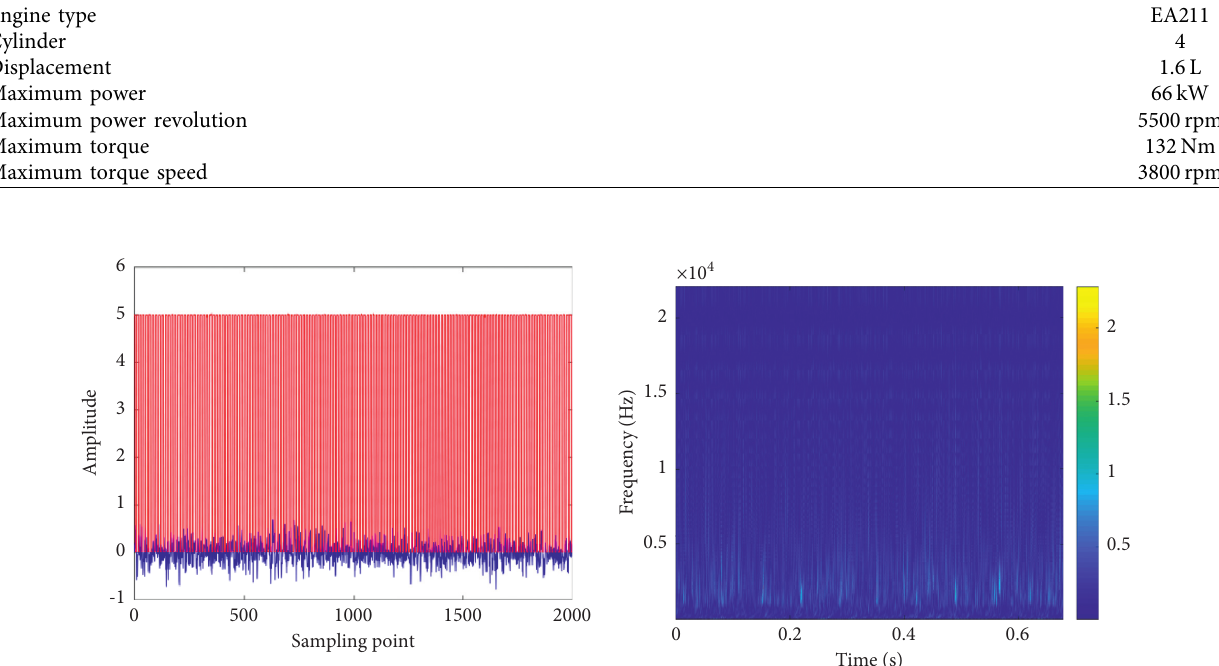
Figure 7: Automobile engine fault detection test bench. (1) Engine; (2) coupling; (3) sound sensor; (4) encoder; (5) data acquisition card; (6) computer. Table 1: Engine parameters.